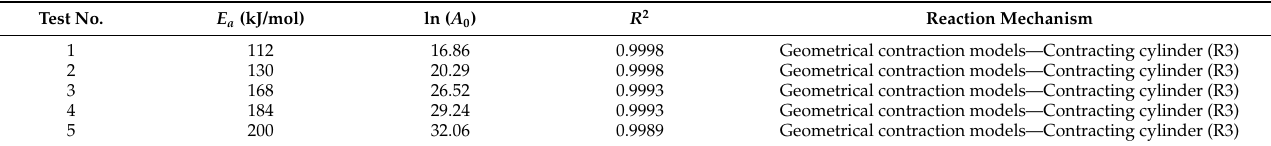
Table 9. Activation energy of mixed polymers pyrolysis by model-fitting methods: